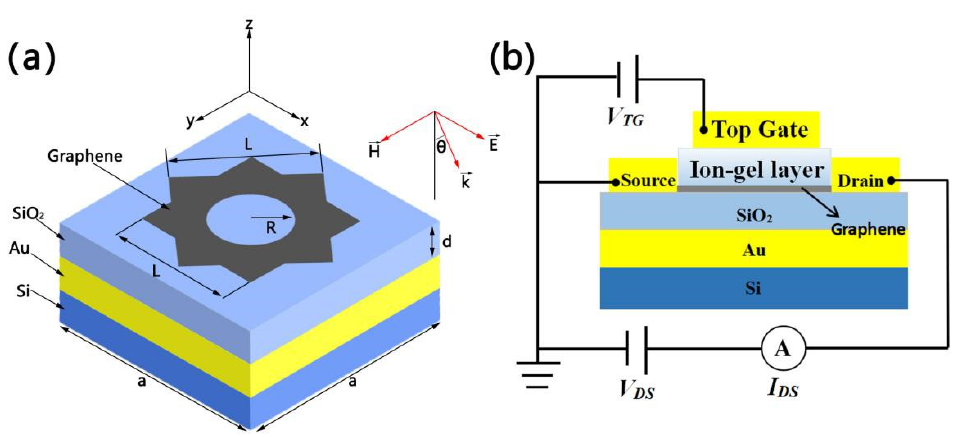
Figure 1. ( a ) Diagrammatic sketch of a unit cell of the square-square-circle graphene array with its geometric parameters and the polarization and propagation of the light source. ( b ) Principle geometry of the top grid structure for the operating Fermi energy of graphene. V TG , V DS and I DS express the top gate voltage, the voltage and current flowing between Source and Drain, respectively.